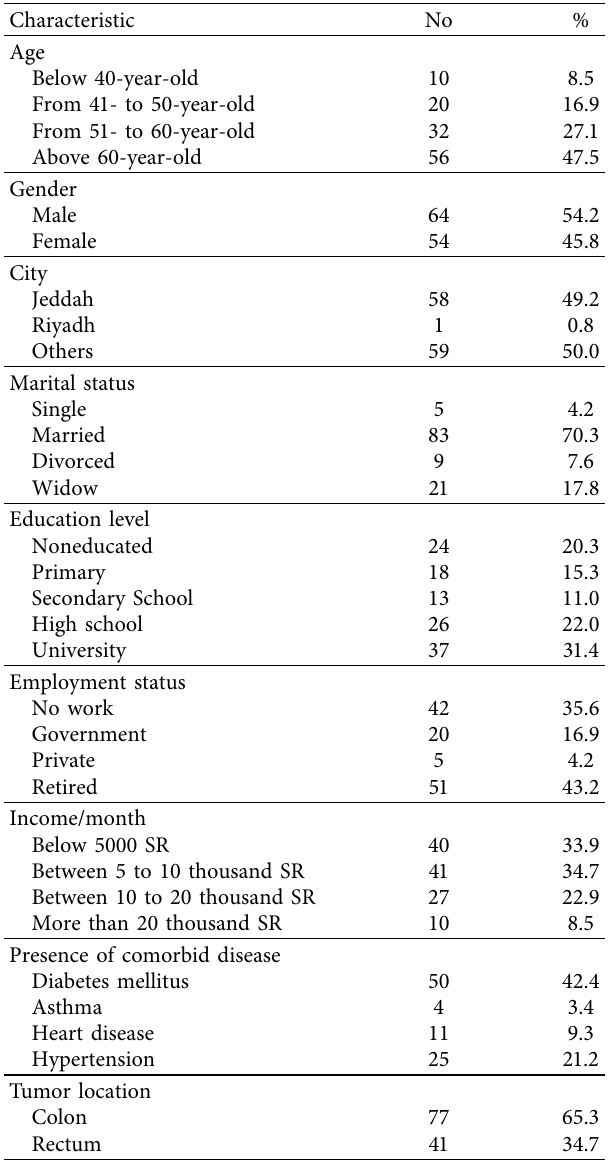
and sexual interest (men) 38.54 (32.10).